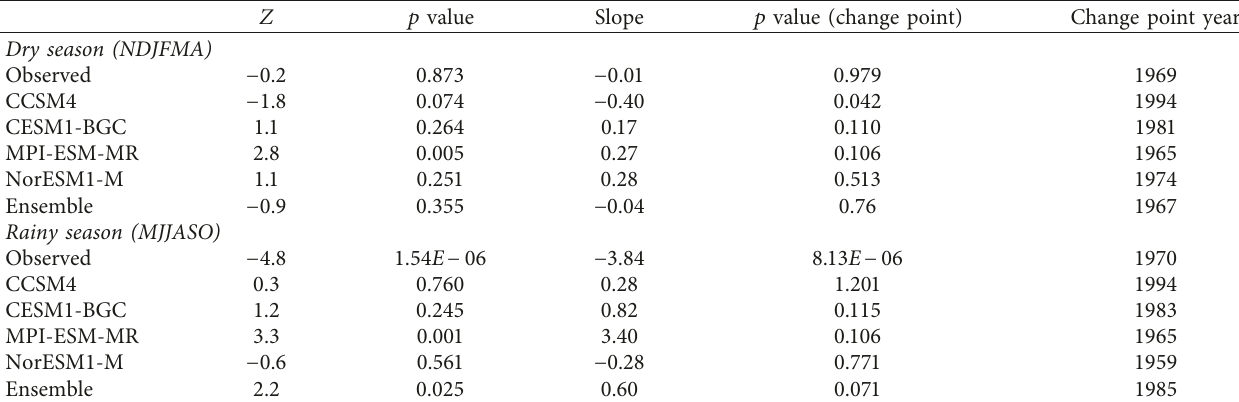
Table 5: Trend test for the Sahel rainy and dry